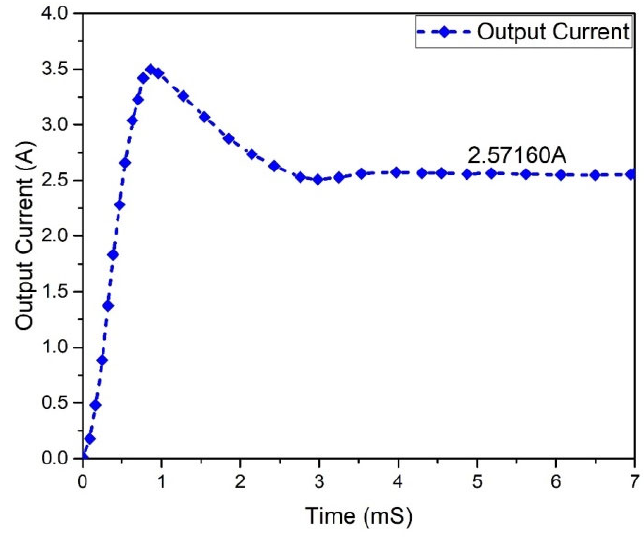
Figure 9. Flyback boost converter output current.